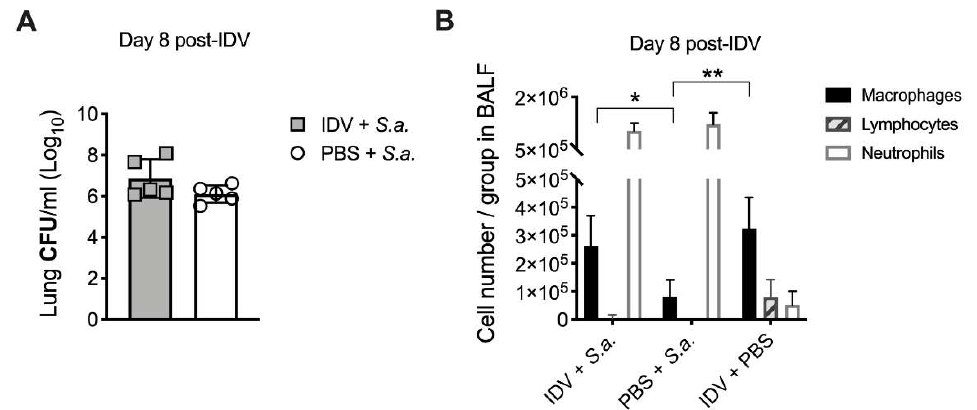
Figure 3. C57BL/6 (WT) mice were inoculated with OK11 (IDV; grey boxes) or PBS (white circles) on day 0 and challenged with S. aureus ( S.a.) or PBS on day 7. ( A ) Lung bacterial burden (CFUs/mL) and ( B ) differential counts of white blood cells from BALF were measured 24 h after S.a. challenge. Experiments had a minimum of five animals per group and were repeated two times. Data are represented as mean ± SD. *, p < 0.05, **, p < 0.01 using Student’s t test.